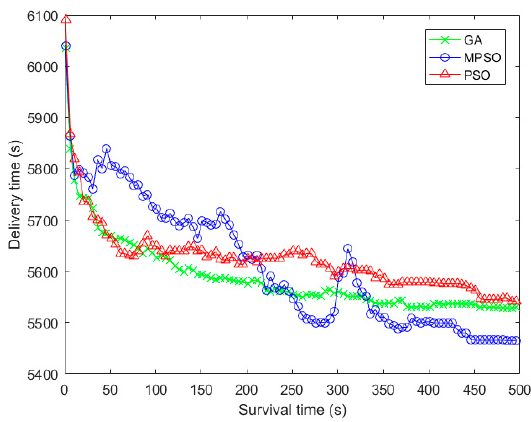
Figure 9. Comparison of delivery time with the iteration times.